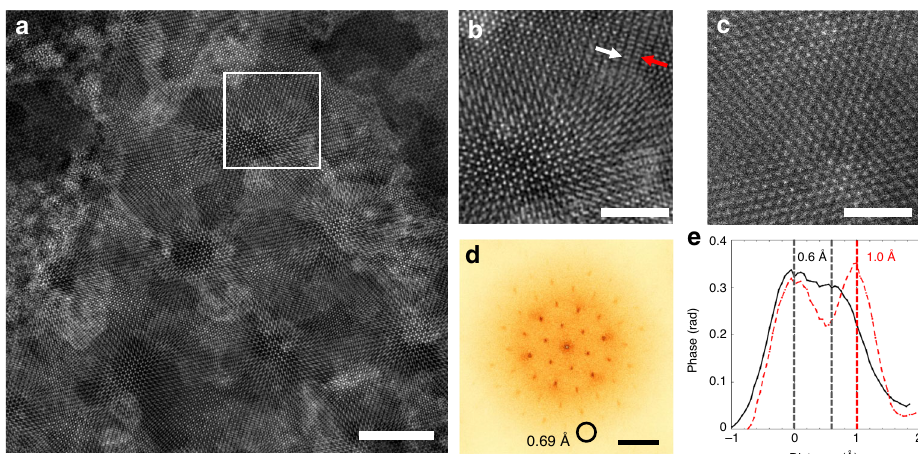
Fig. 2 Mixed-state electron ptychographic reconstruction of a bilayer MoSe 2 /WS 2 sample. a Reconstruction from 128 × 128 diffraction patterns with a scan step size of 2.36 Å, fi eld of view of 30 × 30 nm 2 , and reconstructed pixel size of 0.2 Å, which is close to the pixel size (0.19 Å) in ADF image in c . Scale bar is 5 nm. b Enlarged images from the regions marked by the white rectangular on a and showing the bilayer structure. The white and red arrows point to the atomic pairs for the intensity pro fi les in e . c Conventional annular dark- fi eld (ADF) image from a similar bilayer area acquired in a focused probe condition using the same aperture size and a similar dose as that for ptychography in a . Scale bars in b and c are 2 nm. d Diffractogram of the whole reconstruction in a , the circulated diffraction spot corresponds to a 0.69 Å distance in real space. Scale bar is 0.7 Å − 1 . e Line pro fi les across two atomic pairs pointed by the white and red arrows on b showing atomic column distances of 0.6 and 1.0 Å, respectively.